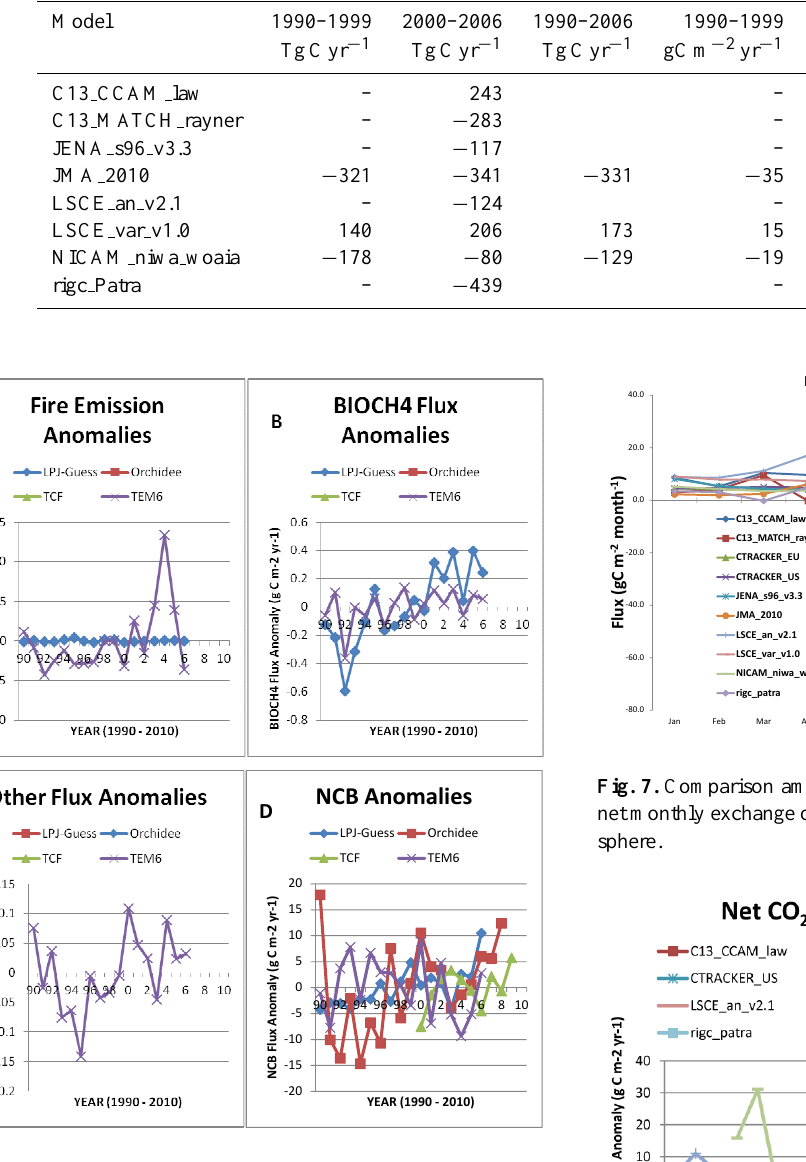
Fig. 6. Comparisons among LPJ-Guess WHyMe, Orchidee, TCF, and TEM of inter-annual variability between 1990 and 2010 for anomalies of fire emissions (Panel A ), biogenic CH 4 emissions (Panel B ), Other fluxes (harvest and DOC exports, Panel C ), and net carbon balance (NCB, Panel D ).